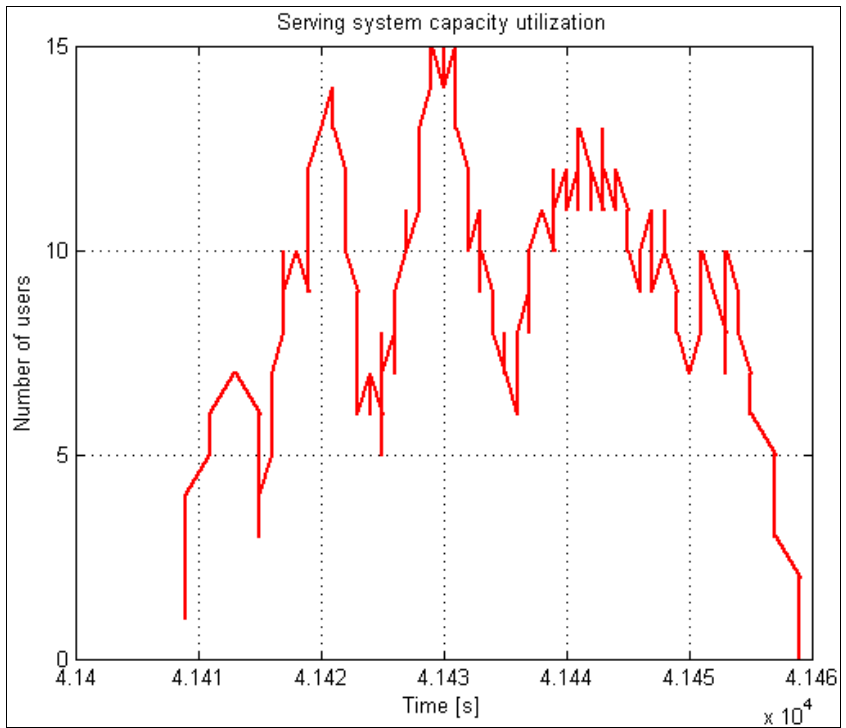
Figure 10. Activity and utilization of the service charging system in the entire observed period. P = 15, U = 75.